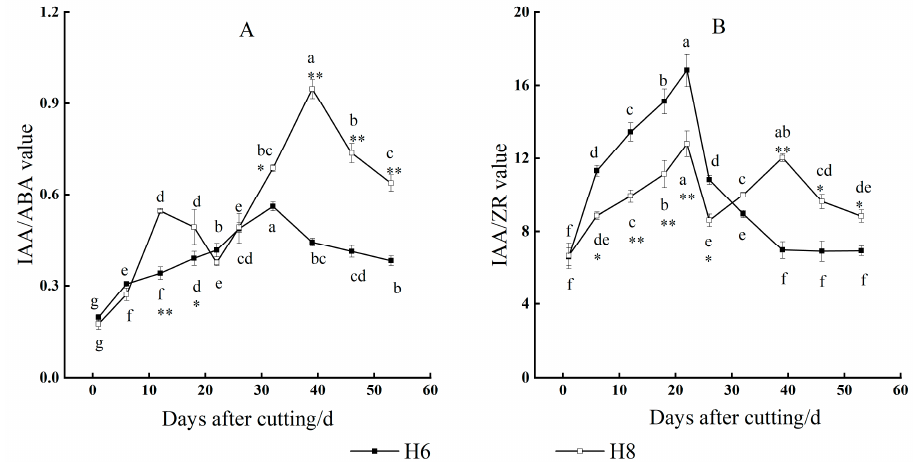
Figure 6. Changes of endogenous hormone content in cutting rooting of H6 and H8 in E. ulmoides. ( A ) Changes in IAA/ABA. ( B ) Changes in IAA/ZR. The data are shown as the means ± SEs ( n = 3). Means with the same letter are not significantly different in the same group. * indicates significant difference between the H6 group and the H8 group at the same time. * and ** indicates means at the level of 0.05 and 0.01,